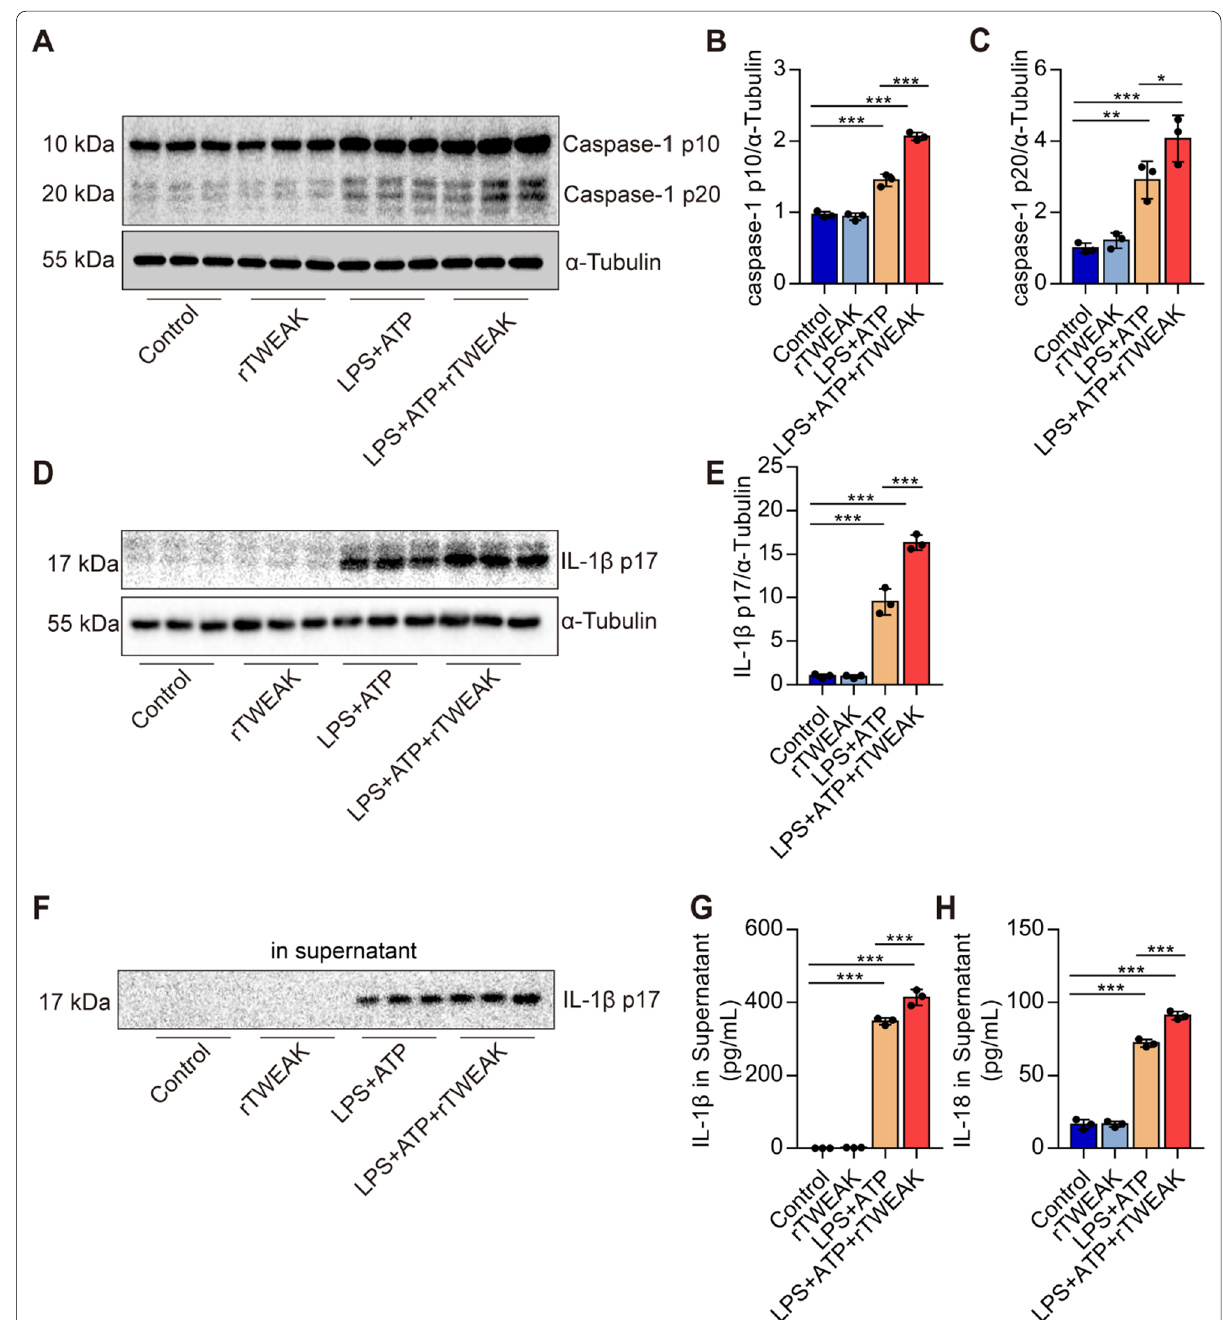
Fig. 7 Pre‑treated with rTWEAK aggravates the activation of NLRP3 inflammasome in macrophages. The cells were stimulated by rTWEAK (100 ng/mL) and LPS (100 ng/mL) for 135 min, and then ATP (2.5 mM) challenged primary macrophages for 45 min. A – C The levels of Caspase‑1 p10 and Caspase‑1 p20 in primary macrophages were determined by Western blot ( n 3). D , E The level of IL‑1β p17 in primary macrophages was = determined by Western blot ( n 3). F The level of IL‑1β p17 in the supernatant of primary macrophages was determined by Western blot ( n 3). = = G The content of IL‑1β p17 protein in the supernatant of primary macrophages was determined by ELISA ( n 3). H The content of IL‑18 protein = in the supernatant of primary macrophages was determined by ELISA ( n 3). Data are expressed as the mean SD. Differences among multiple = ± groups were performed using ANOVA. Tukey’s test was used as a post hoc test to make pair‑wise comparisons. * P < 0.05, ** P < 0.01, and *** P <